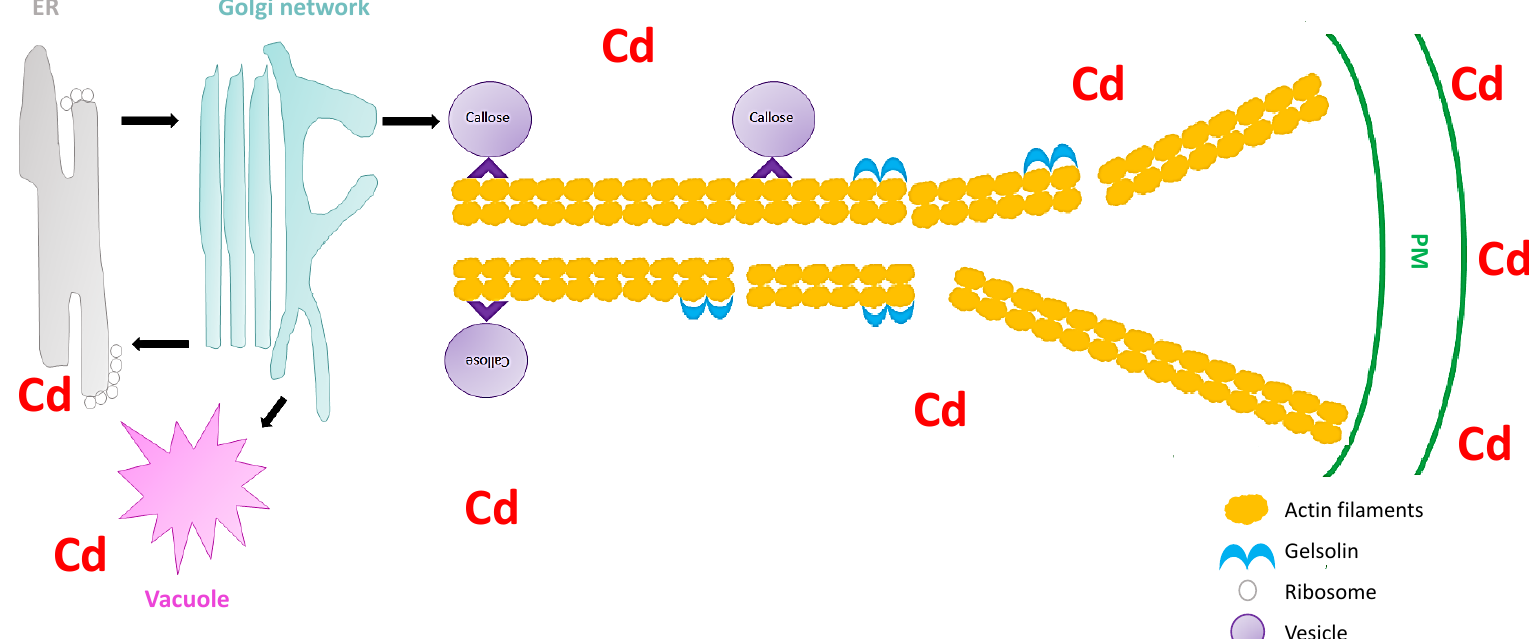
Figure 1. Schematic image showing the severing of the actin filaments by gelsolin under cadmium stress in Arabidopsis thaliana (extrapolated from Fan et al. [55]). The vesicles move (black arrow) between the endoplasmic reticulum (ER), Golgi network, vacuole, and the plasma membrane (PM). Cadmium stress triggers a callose response which are sorted and packaged in vesicles for unloading at the PM. The vesicles attaches to the molecular motors (ˆ) which facilitate the movement on the actin filaments. However, cadmium also activates gelsolin, which cleaves the actin filaments, and therefore the vesicles cannot reach the PM and unload the